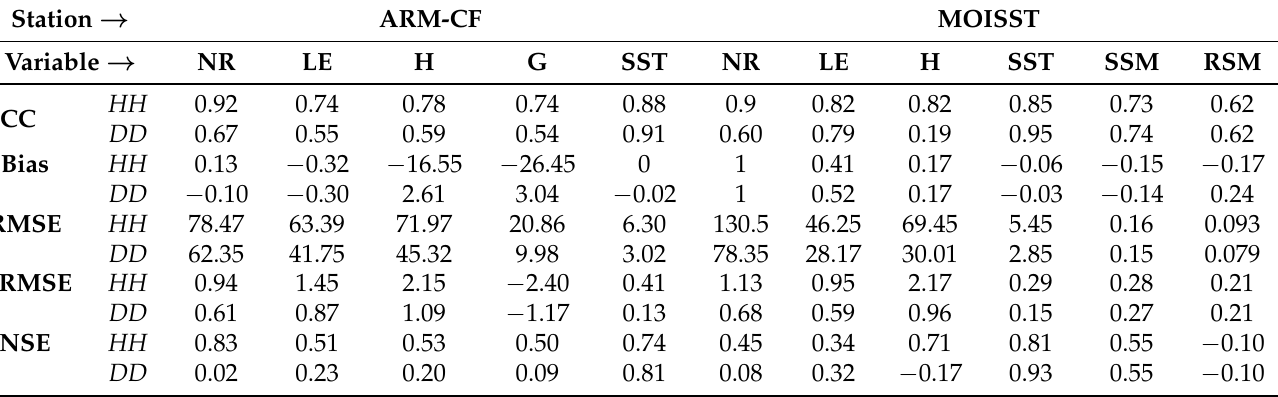
Figure 10. Hourly time series of ( a ) observed precipitation (P; blue bars), ( b ) simulated (red) and observed (black) net radiation (NR, W/m 2 ), ( c ) latent heat flux (LE, W/m 2 ), ( d ) sensible heat flux (H, W/m 2 ), ( e ) soil surface temperature (SST), ◦ C, ( f ) surface soil moisture (SSM, -), and (g) root-zone soil moisture (RSM, -) at MOISST during the ten-day period between 13 August 2014 and 22 August 2014. Table 9. ARM-CF and MOISST validation metrics with respect to observed values at hourly (HH) and daily (DD) resolutions. Net radiation (NR, W/m 2 ), latent heat flux (LE, W/m 2 ), sensible heat flux (H, W/m 2 ), ground heat flux (G, W/m 2 ), soil surface temperature (SST, ◦ C), surface soil moisture (SSM, -), and root-zone soil moisture (RSM, -). The statistical metrics are correlation coefficient (CC), bias, root mean squared error (RMSE), normalized RMSE (NRMSE), and Nash–Sutcliffe model efficiency coefficient